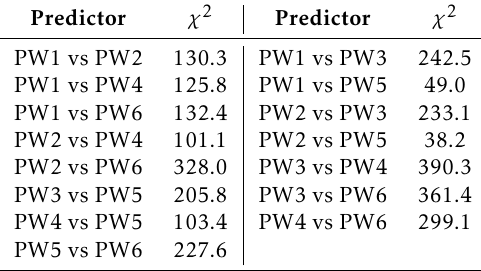
However, this was not the case when passwords were displayed. It is obvious that displaying passwords played a role in users’ perception of trust, which led to very di ff erent responses among all participants (likely driven by their di ff erent behavioral